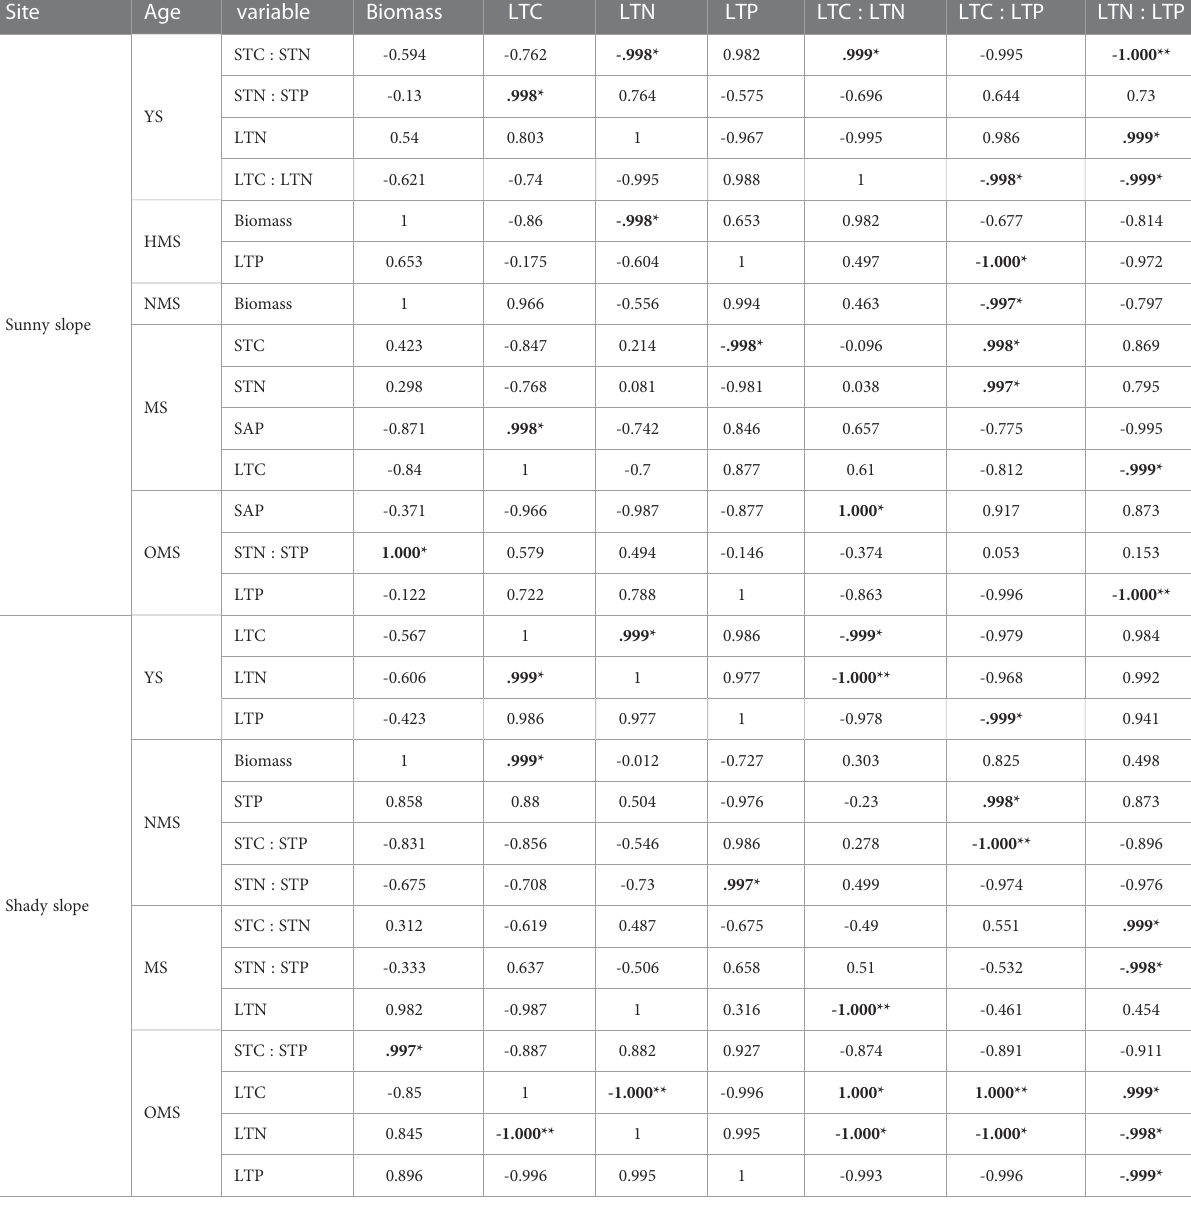
TABLE 2 Correlations of leaf biomass and ecological stoichiometry with soil ecological